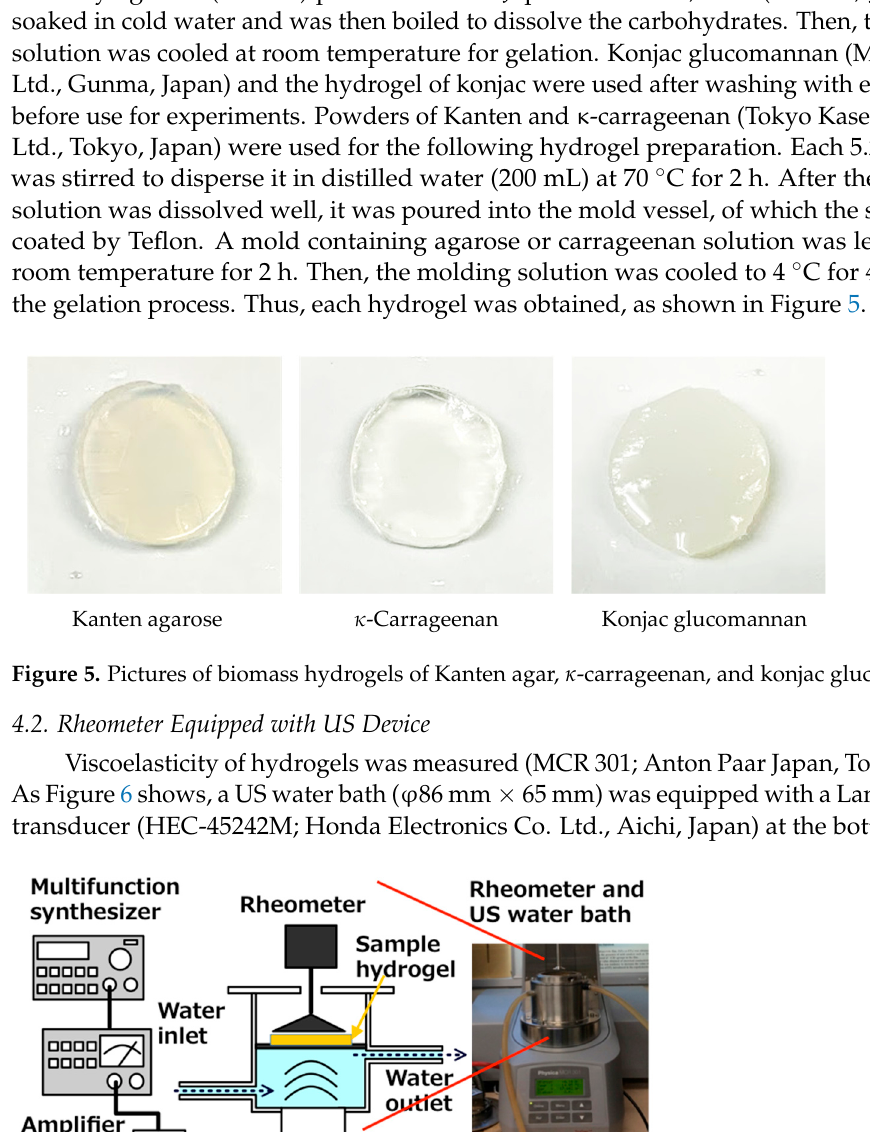
Figure 7. Time change in ( a ) water bath temperature in the absence and presence of water circulation and ( b ) G* in the absence and presence of US exposure for 3 min intervals. When the hydrogel sample was placed on the sample SUS plate on the US water bath, 5 mL water was dropped between the hydrogel and the sample stage. The rheometer was worked to rotate the rotor rod, which was placed on the hydrogel surface, with 0.01–100% of mechanical strain to the hydrogel sample. For the present study, the US was operated while mechanical deformation was occurring on the hydrogel. At the same time, the hy- drogel viscoelasticity was measured. In the cases without a hydrogel sample in the water on the plate, the G* values of 0.05–0.2 Pa observed by the US operation were extremely